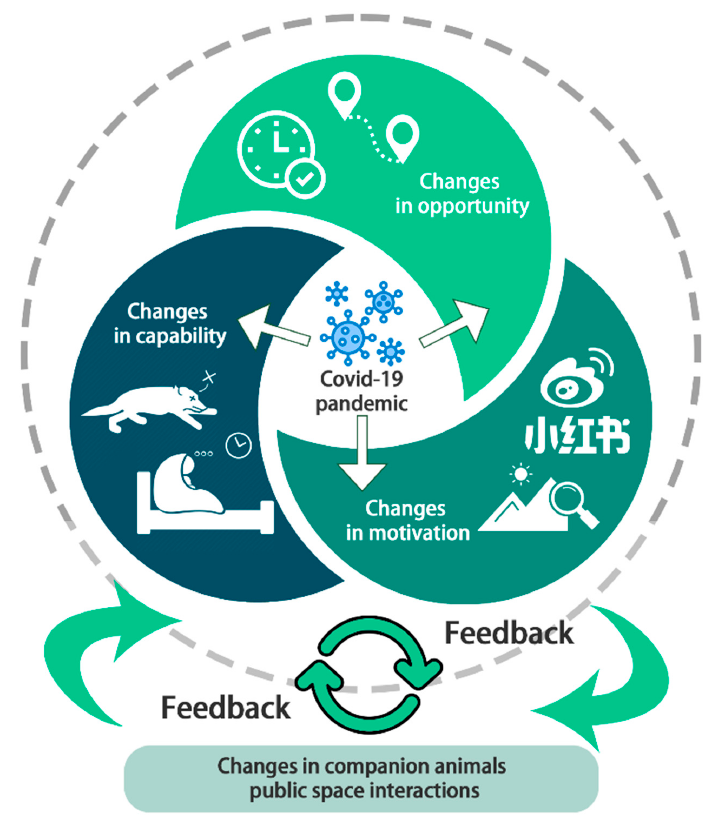
Figure 14. A conceptual framework of pandemic influences on the direct interaction of humans and their pets with “companion animals” public and pseudo-public their pets with “companion animals” public and pseudo-public spaces.